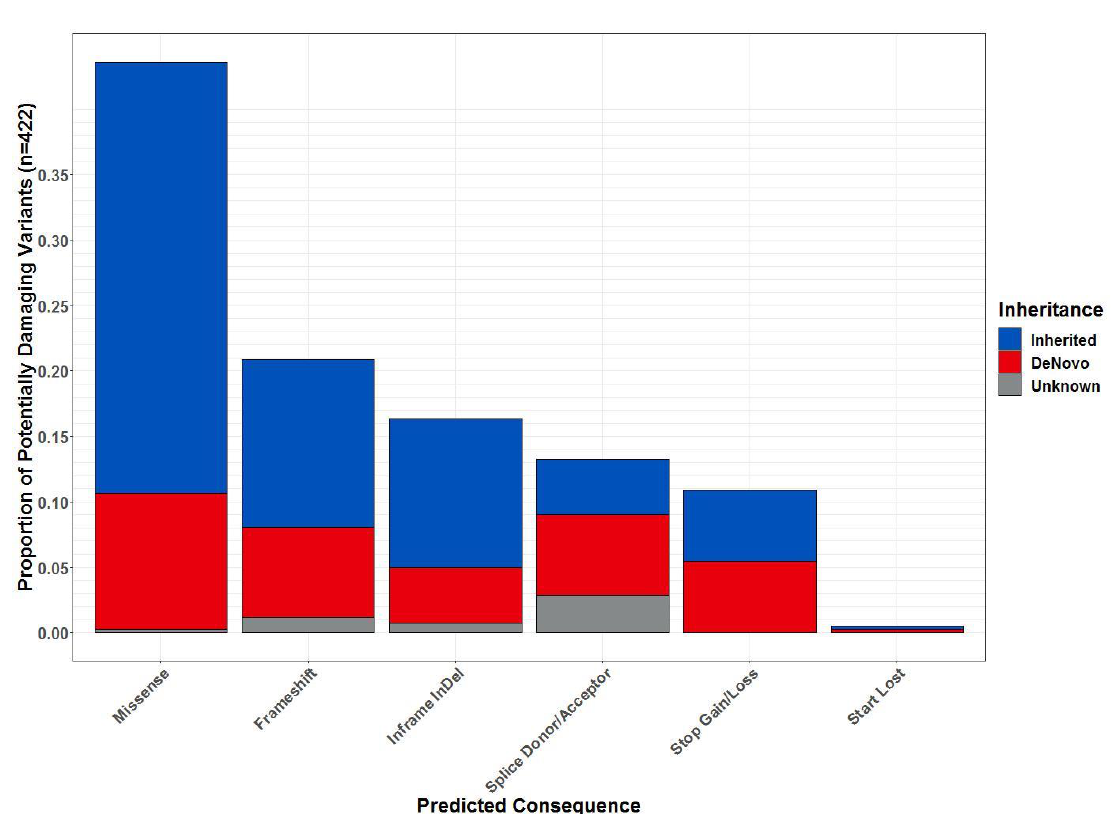
Figure 2. Predicted protein consequences of potentially damaging variants in affected children (Families A–D). Shown are the frequencies of Variant Effect Predictor consequences for variants identified in five affected children that were highly or moderately likely to damage the protein product. Data were not included for the affected child from Family E as the parents’ data were unavailable. Colors indicate variant consequences that were inherited (blue), de novo (crimson), or unknown (grey = uncharacterized Mendelian violations, or improbable homozygous de novo). Int. J. Mol. Sci. 2021 , 22 , x FOR PEER REVIEW